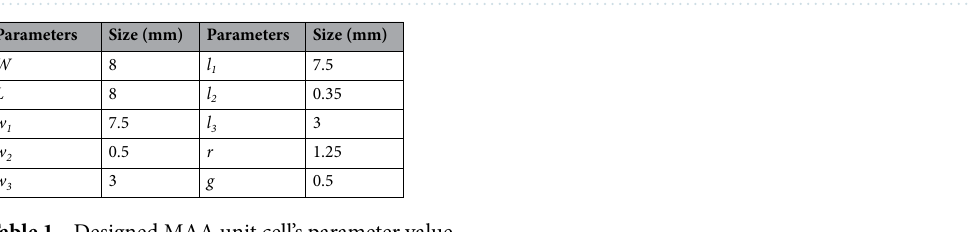
Table 1. Designed MAA unit cell’s parameter